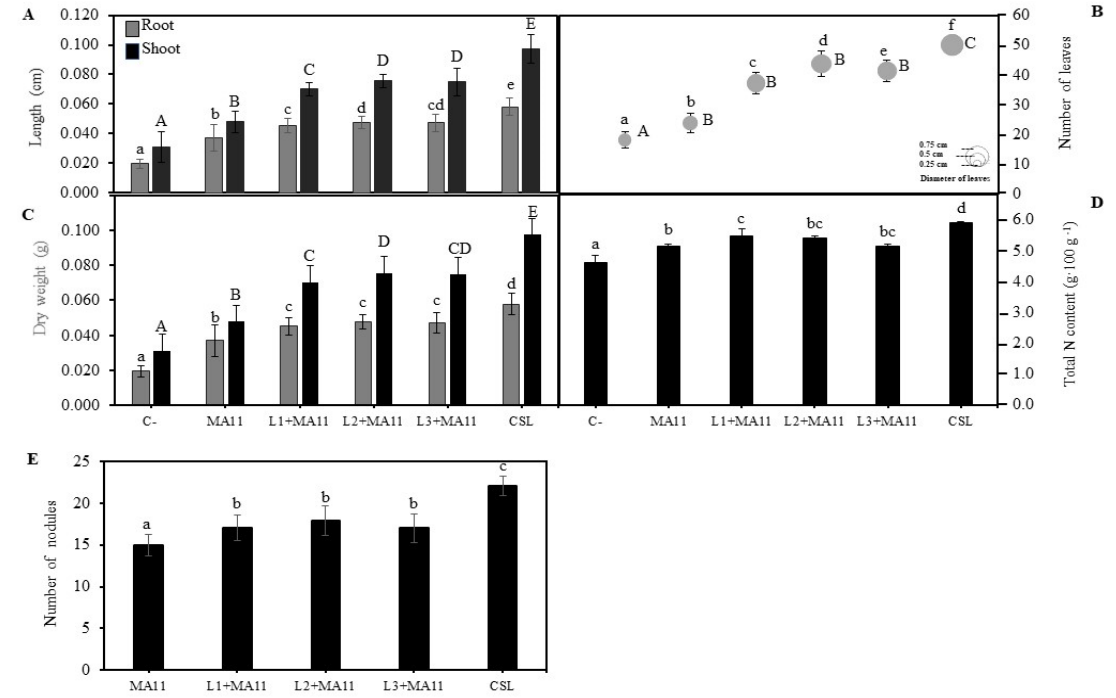
Figure 3. Effects of selected PGPR in M. sativa under greenhouse conditions in nutrient-poor soils. ( A ) Length of shoots and roots of M. sativa plants after 60 days. Values are mean ± S.D. ( n = 16). Different letters indicate means that are significantly different from each other. Lowercase and uppercase letters are used to qualify different variables and are not comparable among them (one-way ANOVA; LSD test, p < 0.001). ( B ) Number and size of leaves in plants of M. sativa after 60 days from germination. Values are mean ± S.D. ( n = 16). The size of the circles indicates the mean of the diameter of the leaves. Different letters indicate means that are significantly different from each other. Lowercase letters are used to qualify the number of leaves per plant and uppercase letters are used to qualify the diameter of leaves and are not comparable among them (one-way ANOVA; LSD test, p < 0.0001). ( C ) Dry weight of shoots and roots of M. sativa plants after 60 days from germination. Values are mean ± S.D. ( n = 16). Different letters indicate means that are significantly different from each other. Lowercase and uppercase letters are used to qualify different variables and are not comparable among them (one-way ANOVA; LSD test, p < 0.001). ( D ) Nitrogen content in plants of M. sativa after 60 days from germination. Values are mean ± S.D. ( n = 16). Different letters indicate means that are significantly different from each other. Lowercase and uppercase letters are used to qualify different variables and are not comparable among them (one-way ANOVA; LSD test, p < 0.001). ( E ) Number of nodules in plants of M. sativa after 60 days from germination. Values are mean ± S.D. ( n = 16). Different letters indicate means that are significantly different from each other (one-way ANOVA; LSD test, p < 0.0001). C-: without inoculation; MA11: inoculation with strain MA11; L1+MA11: inoculation with strains L1 and MA11; L2+MA1: inoculation with strains L2 and MA11; L3+MA11: inoculation with strains L3 and MA11; CSL: inoculation with a consortium of strains L1, L2, L3, and MA11.